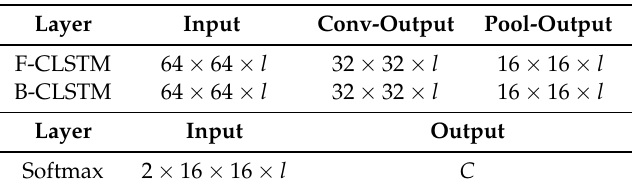
Table 5. The dimension of each layer in